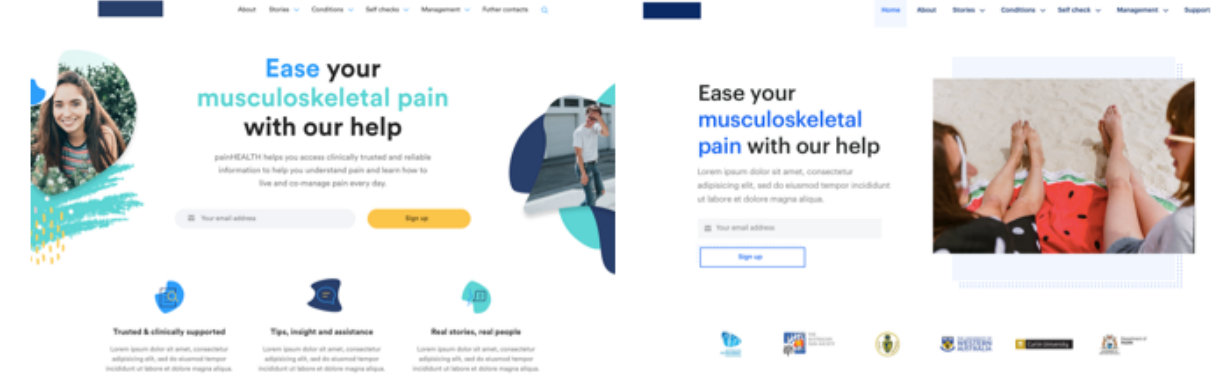
Participants completed the same 4 tasks across each of the 3 websites (Multimedia Appendix 2). Each test task